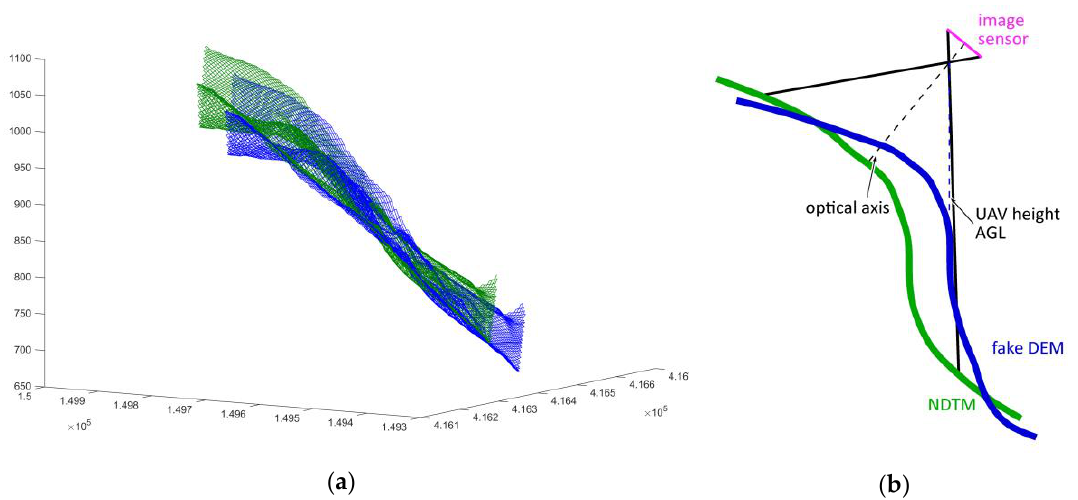
Figure 7. Fake DEM and NDTM: ( a ) Graphical 3D comparison of fake DEM (blue) and NDTM (green) of the case study. The fake DEM is shifted so at 80 m above the fake DEM the distance camera-ground (DCG) at pitch angle — 45 degrees is 60 m and ( b ) oblique image acquired using fake DEM in mission planning. When approaching a steep feature, the fake DEM guides UAV to back o ff from the terrain to keep the DCG